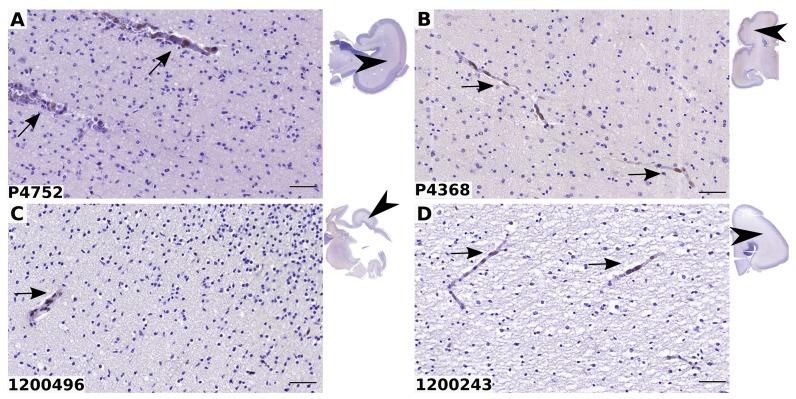
PPARγ expression is not detected in the white matter of HCMV-infected fetal brains.Shown are representative results of immunohistological staining of brain sections from fetuses infected by HCMV (A, B) or from controls (C, D). The reference number of each donor is indicated at the bottom left of each panel. Clinical details are summarized in Table 1. PPARγ positive cells (arrows) are detected in the vessels but not in the white matter in patients and controls. Insets show the localization of the optical field within the brain sections (arrowheads). Scale bar: 50 μm.